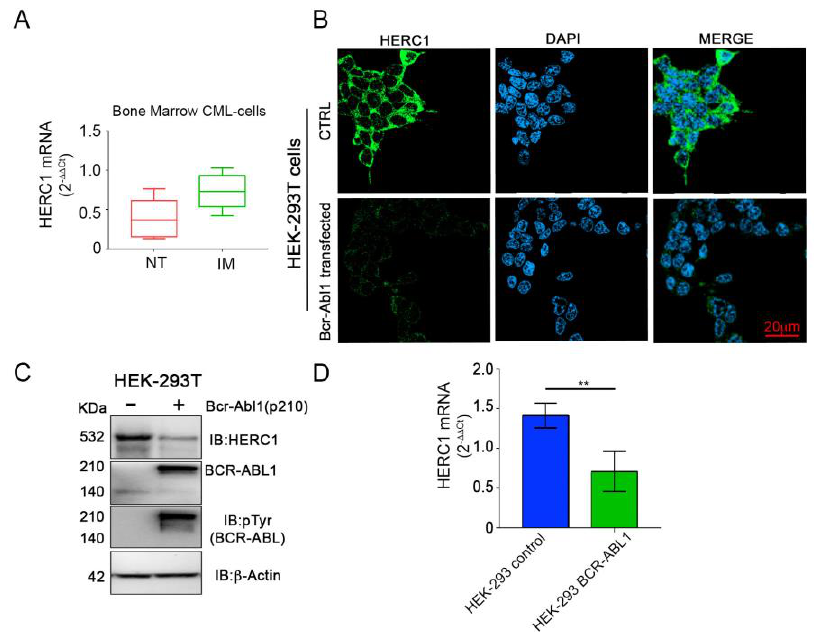
Figure 5. HERC1 mRNA and protein amounts are regulated by the Bcr-Abl1 tyrosine kinase activity. ( A ) Primary bone marrow derived from leukemic cells of newly diagnosed CML patients ( n = 5) displayed a modest increase in HERC1 mRNA quantity after in vitro Imatinib (2.5µM) treatment. ( B , C ) HEK-293T transiently and exogenously expressing the constitutively active p210 BCR-ABL1 tyrosine kinase exhibited a severe down-modulation of HERC1 protein examined by immunofluorescence ( B ) and Western Blot ( C ). DAPI staining (blue) indicated the cells nuclei while the green signal was corresponding to HERC1 protein. ( D ) HERC1 mRNA level was significantly reduced in HEK-293T overexpressing the BCR-ABL1 (** p < 0.01).